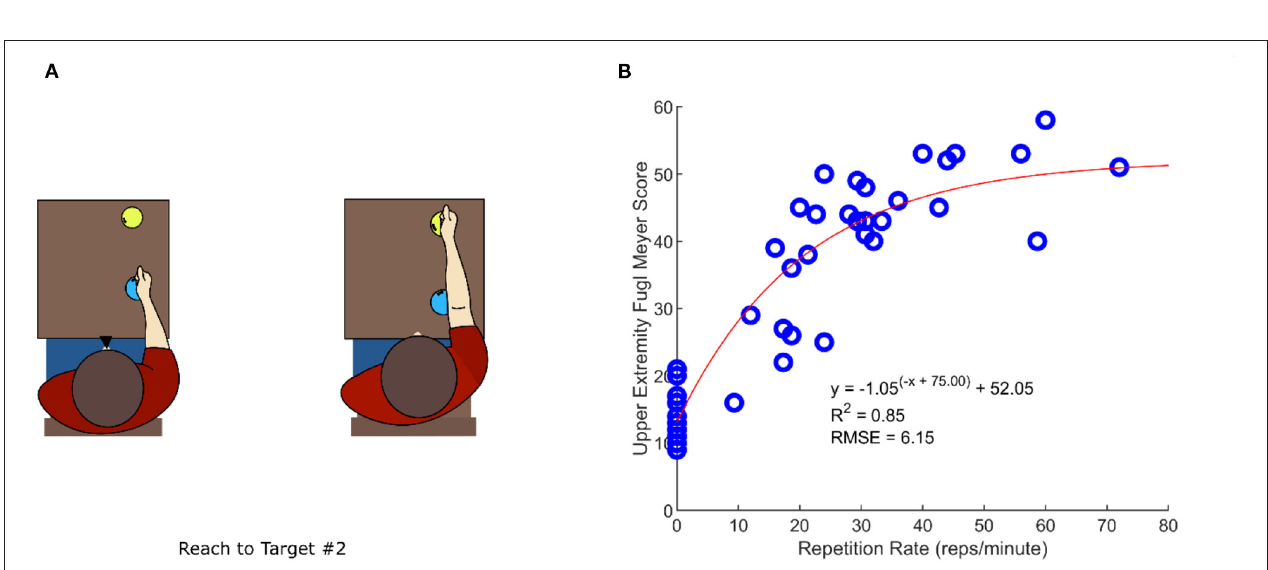
FIGURE 5 | Identifying a system measurement that relates to clinically-measured, upper extremity impairment. (A) “Reach to Target #2” exercise diagram (B) Relationship between the Upper Extremity Fugl-Meyer (UEFM) score, assessed by a rehabilitation therapist, and repetition rate of the “Reach to Target #2” exercise. Shown is an exponential curve fit with the associated statistics.